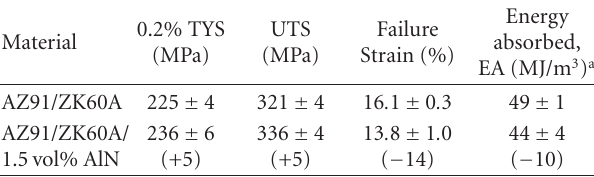
Table 3: Results of tensile testing of AZ91/ZK60A and AZ91/